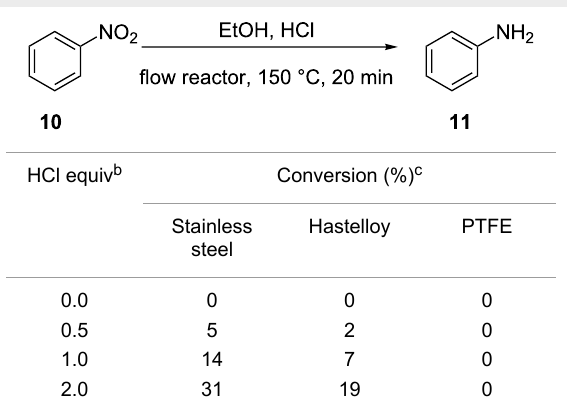
Table 1: Conversion of nitrobenzene ( 10 ) to aniline ( 11 ) in different flow environments. a